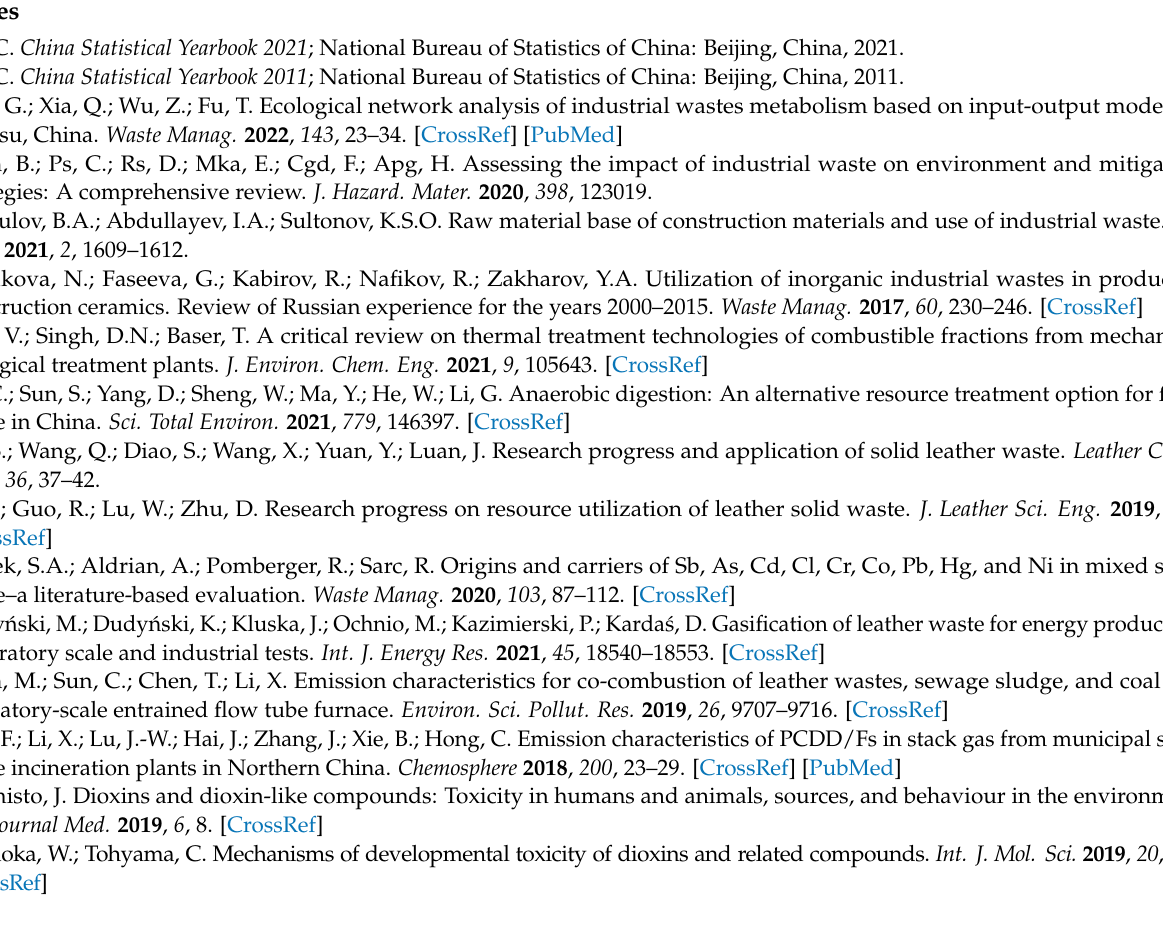
Table S4: Information of recovery standards added during pre-treatment of PCDD/Fs; Table S5: Instrumental parameters of PCDD/Fs analysis of gas chromatography/high-resolution mass spec- trometry